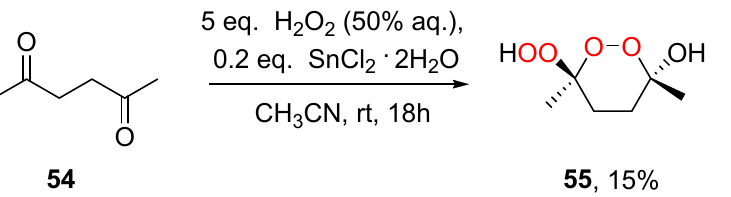
Scheme 20. Synthesis of dihydroperoxy-1,2-dioxolane 53 from acetylacetone 52 . Scheme 21. Synthesis of hydroxyhydroperoxy 1,2-dioxane 55 from 2,5-heptadione 54